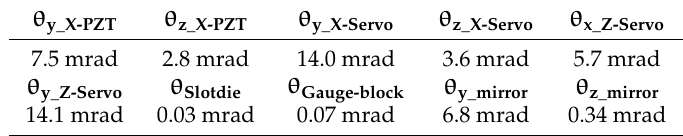
Figure 9. Schematic of angular alignment errors evaluation of the reflective mirror of the laser interferometer. Table 1. Summary of the angular alignment errors of the positioning